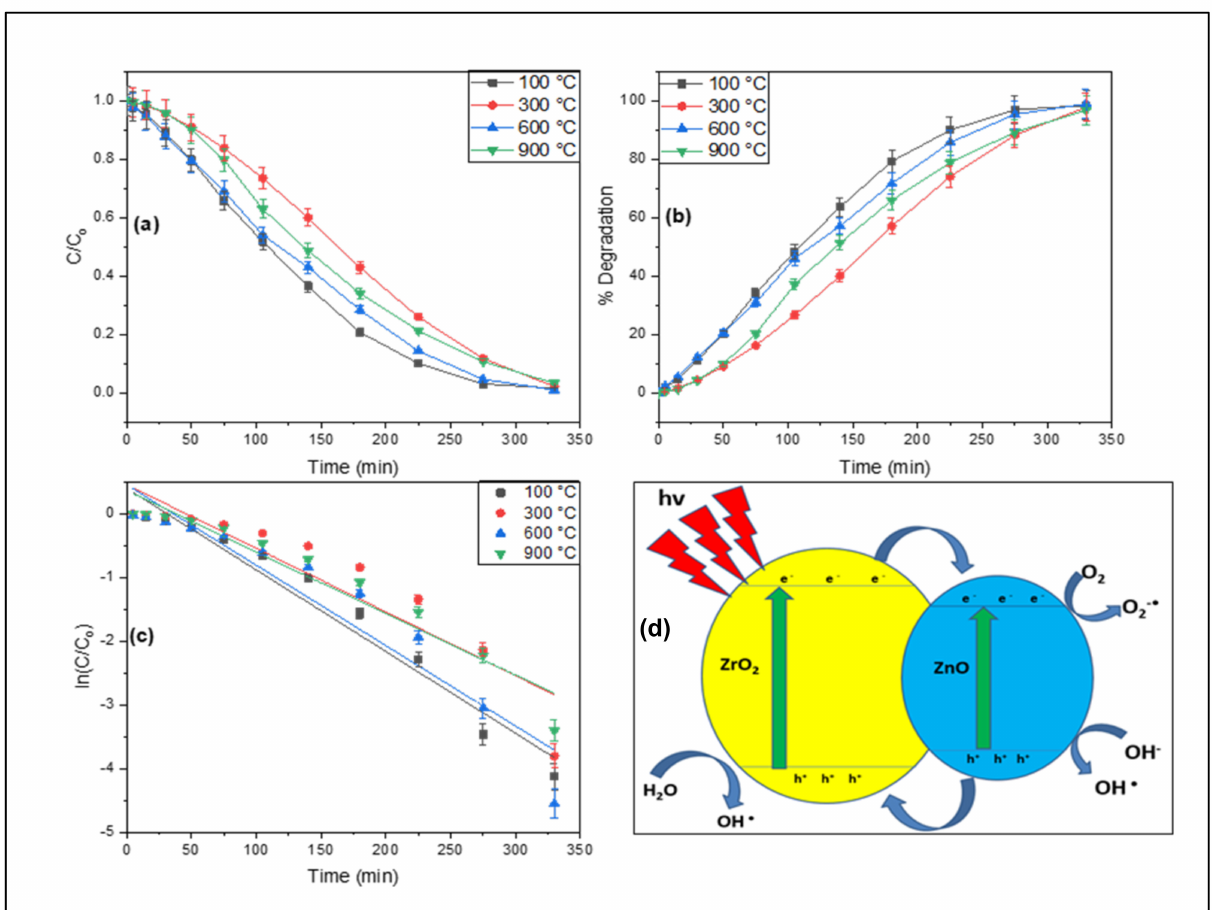
Figure 6. The photocatalytic degradation of rhodamine 6G; ( a ) degradation profile, ( b ) percent degradation, ( c ) kinetic plots, and ( d ) schematic diagram representing excitation of electron and hole